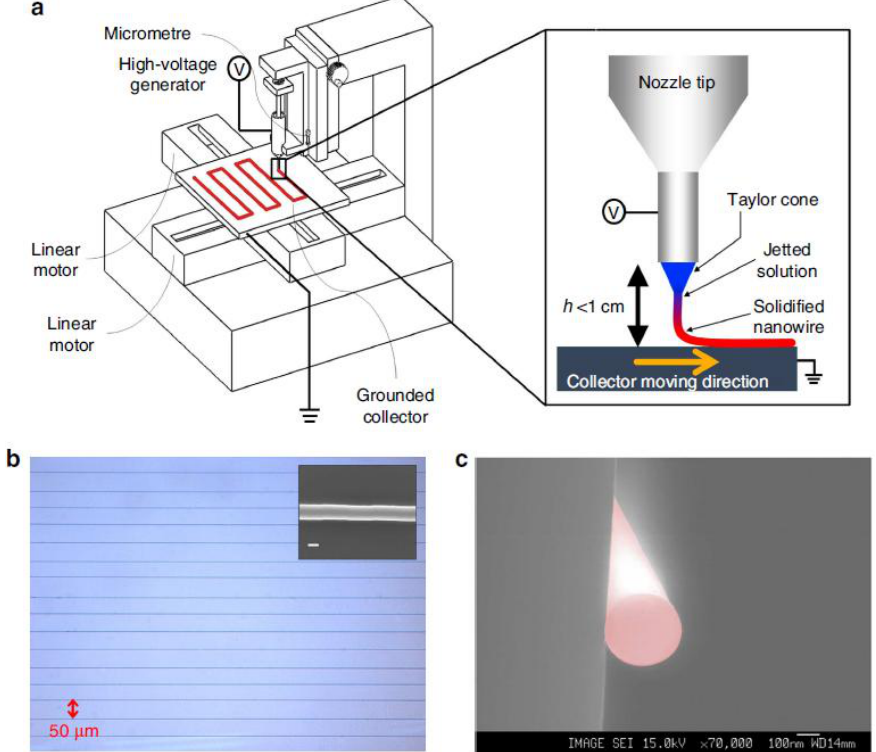
Figure 15. ( a ) Schematic diagram of organic nanowire (ONW) printer and nanowire (NW) printing process; ( b ) optical micrograph of well-aligned NWs (inset, scale bar, 200 nm) and ( c ) field emission scanning electron microscope image showing cross section of well-aligned NW, which forms a perfect circle. Reprinted with permission from